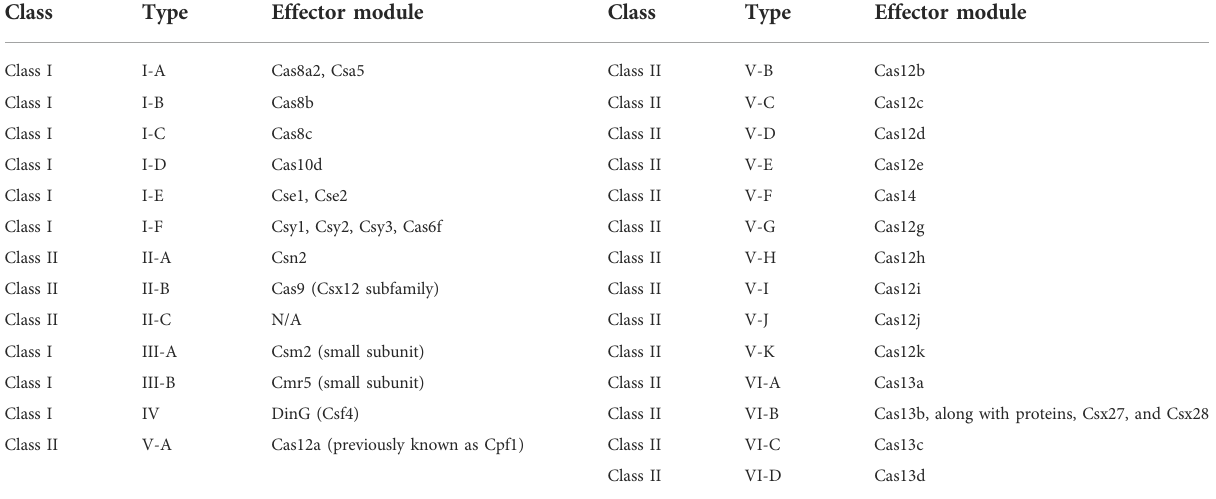
TABLE 1 Classi fi cation of the identi fi ed CRSIPR-Cas